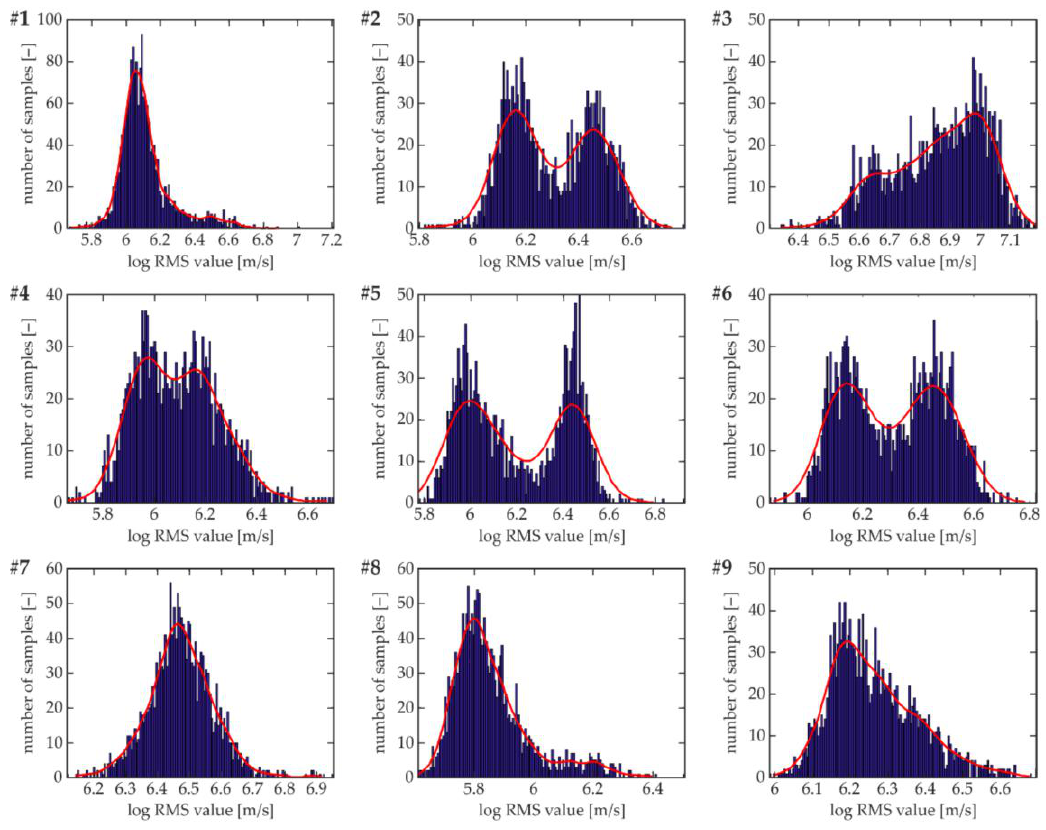
Figure 17. Histogram of WRMS values for specimens #1–#9 ( T = 3.00 ms, w r = r 2